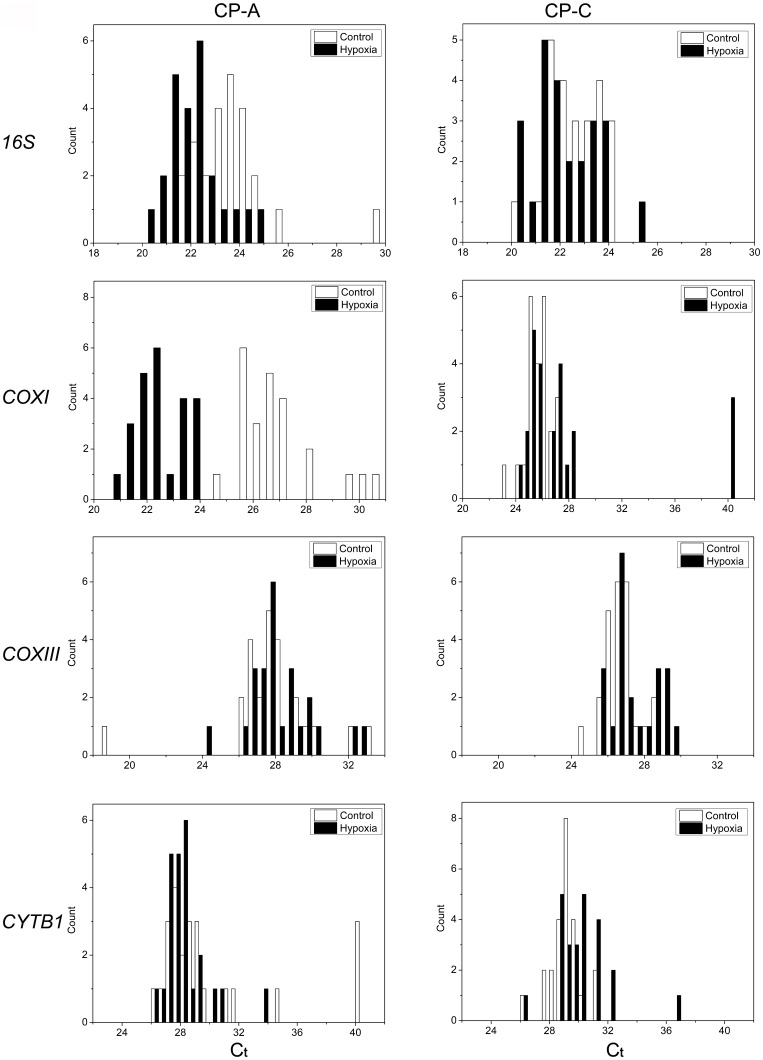
Expression levels of mitochondrially encoded genes (16s rRNA and COXI) in single control and hypoxia-treated CP-A and CP-C cells.Histograms of gene-expression levels in control (empty bars) and hypoxia-treated (30 minutes, solid bars) CP-A and CP-C cells. The distribution histograms were generated using the same bin size.